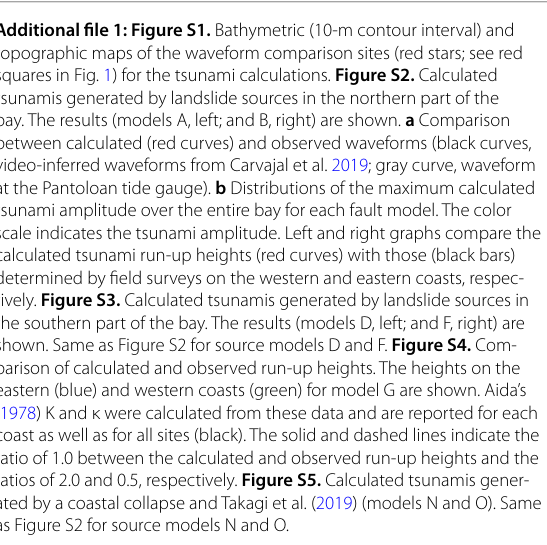
tively. Figure S3. Calculated tsunamis generated by landslide sources in the southern part of the bay. The results (models D, left; and F, right) are shown. Same as Figure S2 for source models D and F. Figure S4. Com- parison of calculated and observed run-up heights. The heights on the eastern (blue) and western coasts (green) for model G are shown. Aida’s (1978) K and κ were calculated from these data and are reported for each coast as well as for all sites (black). The solid and dashed lines indicate the ratio of 1.0 between the calculated and observed run-up heights and the ratios of 2.0 and 0.5, respectively. Figure S5. Calculated tsunamis gener- ated by a coastal collapse and Takagi et al. (2019) (models N and O). Same as Figure S2 for source models N and